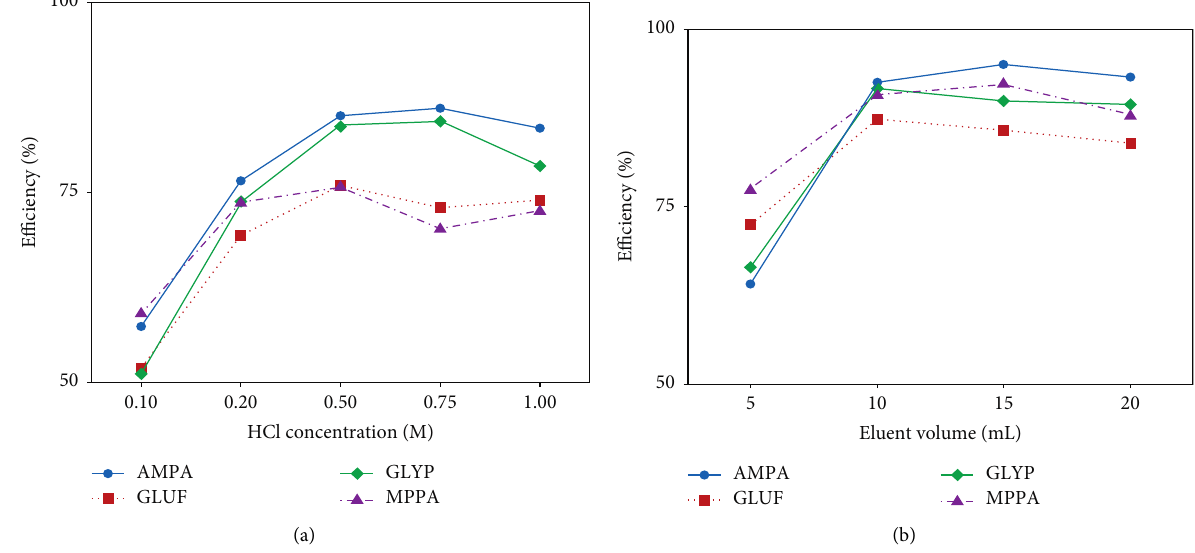
Figure 3: Electropherogram for the optimization of SPE procedures. CE conditions: voltage: 20kV from the detection side; uncoated fused silica capillary with ID � 50 µ m, Lt � 70cm, and Leff �